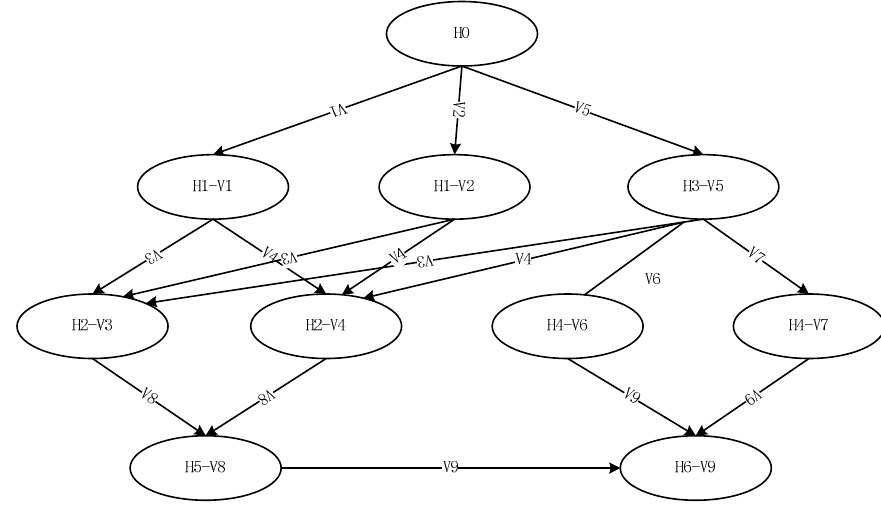
Figure 5. Attack Graph With Node Path Not Weighted.